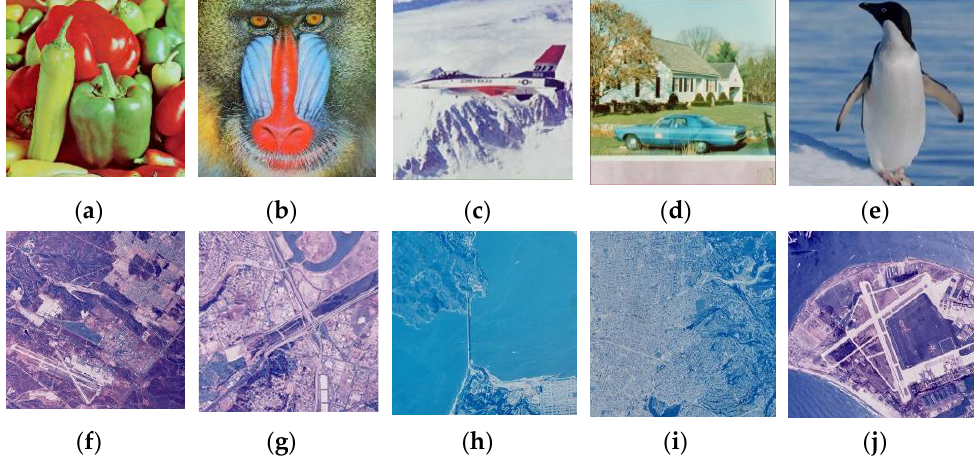
Figure 12. Color plain images: ( a ) Peppers; ( b ) Baboon; ( c ) Airplane; ( d ) House; ( e ) Penguin; ( f ) Sky; ( g ) Railway; ( h ) Sea; ( i ) Water; ( j ) Building.